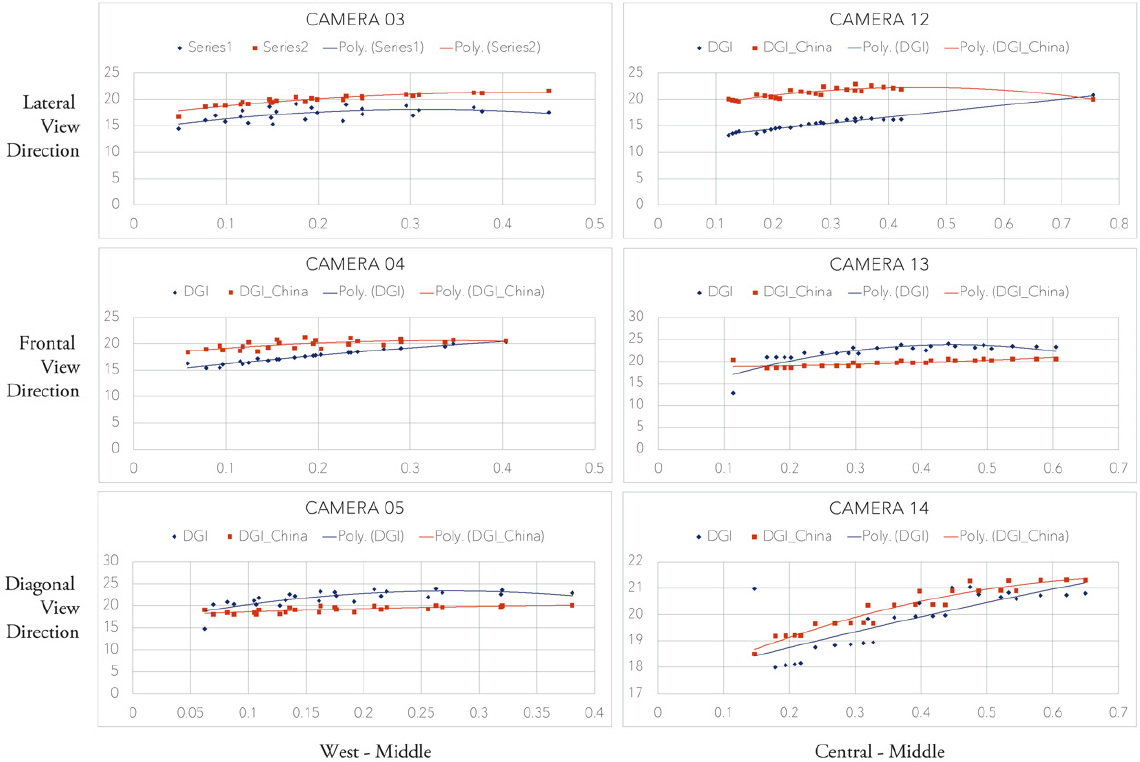
Figure 9. Comparative study on camera viewing location at the center of the room with solid angles ( X -axis) against DGI and DGI China evaluation ( Y -axis).